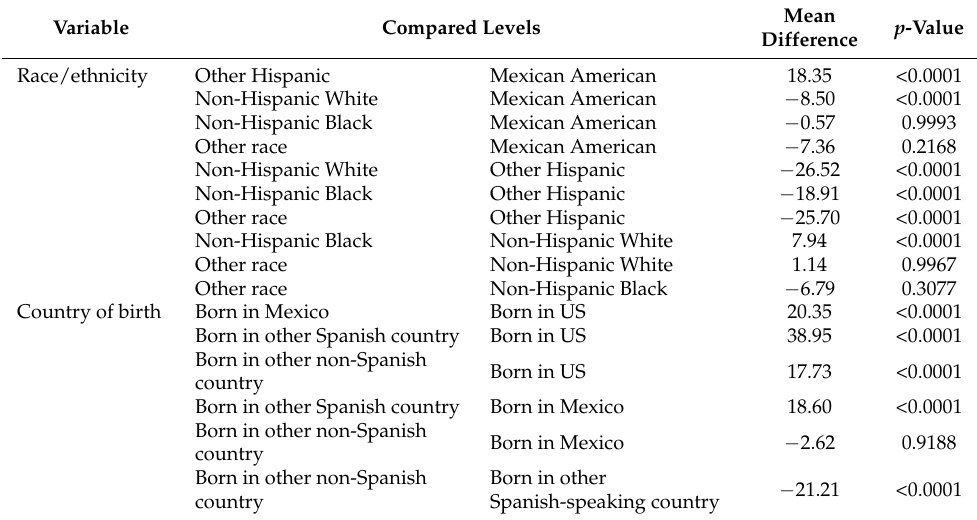
Table 4. Tukey multiple comparisons of means analysis of T. gondii IgG antibody among different race/ethnicity and country of birth. Variable Compared Levels